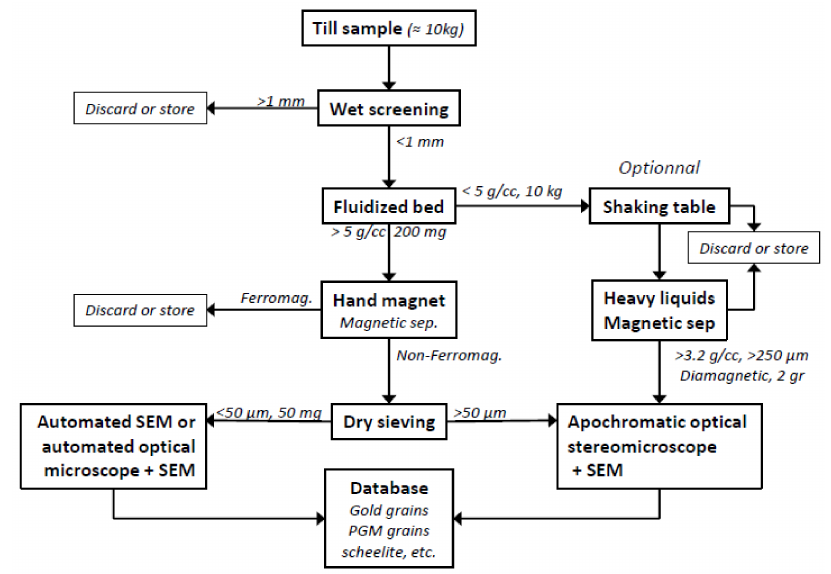
Figure 2. Schematized flow chart of the till sample processing of the improved method. It should be noted that the optimized sluice box can be placed as a feeding apron to a shaking table to recover gold grains or other heavy minerals larger than 250 µ m.